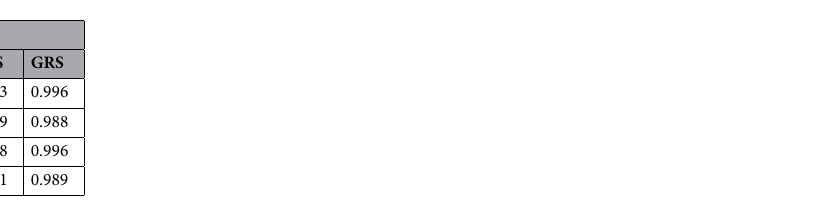
Figure 17. Fitted curves of experimental data and the improved Gompertz two-factor coupled model ( a ) RS, ( b ) NRS, and ( c ) GRS.